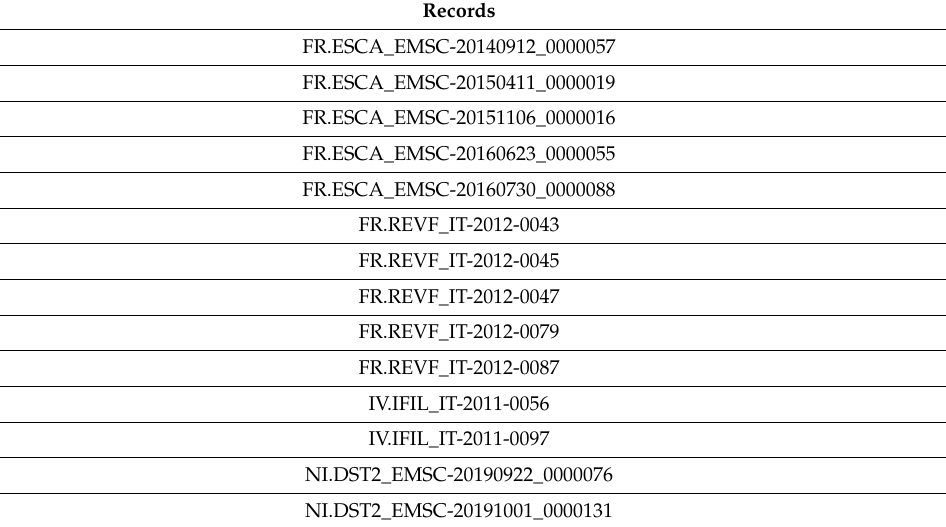
Figure 9. Example of peculiar δ W o , es residual due to a possible issue with the acquisition parameters. ( a ) δ W o , es residuals of the event IT-2011-0056. The filled squares indicate the anomalous δ W o , es values at the IV.IFIL seismic station. ( b ) R es residuals relative to the recording of the IT-2011-0056 event at the IV.IFIL seismic station. ( c ) Evolution in time of the total residuals of the PGA on both the broadband (HH) and medium band (EH) velocimetric sensors at the IV.IFIL seismic station. ( d ) Same for Sa 1s. Table 2. Anomaly due to a possible issue with the acquisition parameters (format: network code.station code_event